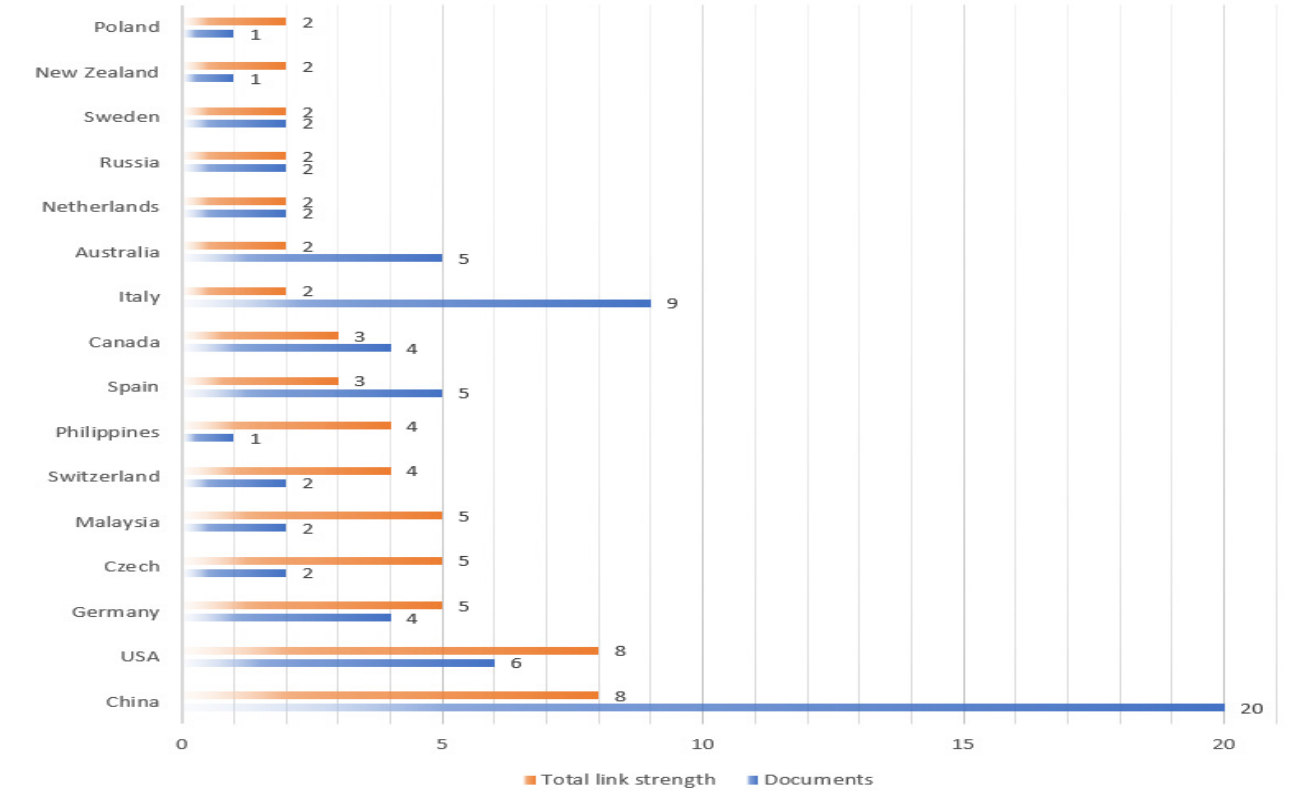
Figure 7. The most active countries/regions.